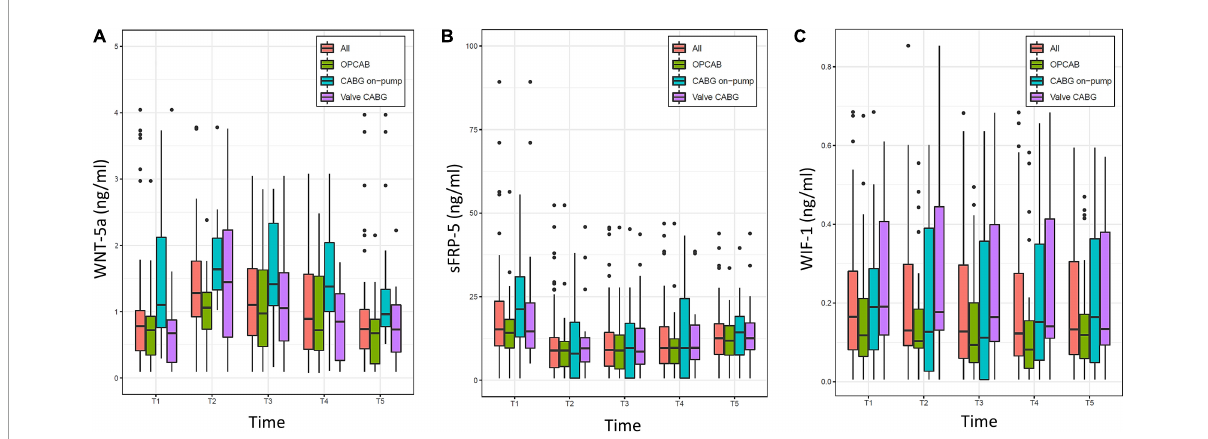
FIGURE3 Evolution of (A) Wingless-related integration site 5a (WNT-5a), (B) Secreted frizzled-related protein 5 (sFRP-5), and (C) WNT inhibitory factor 1 (WIF-1) over time (T1–T5) in the overall population (All) and the three groups (OPCAB, CABG on-pump, and valve-CABG). Values are presented as median and interquartile range (IQR) (box), within 1.5 × IQR (line) and outliers (dots). T1, baseline; T2, time of intensive care unit (ICU) admission; T3, 4 h after surgery; T4, 8 h after surgery; T5, 48 h after surgery; CABG, coronary artery bypass grafting; OPCAB, off-pump coronary artery bypass grafting.